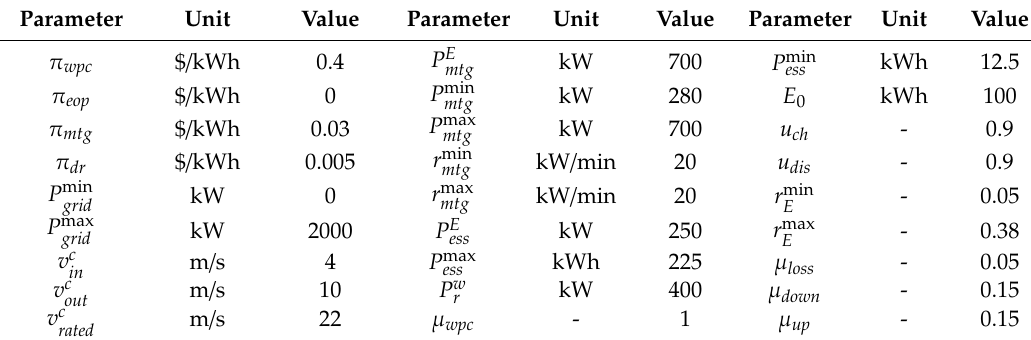
Table 3. Optimal operation strategy cost of a microgrid in three cases. DR: demand